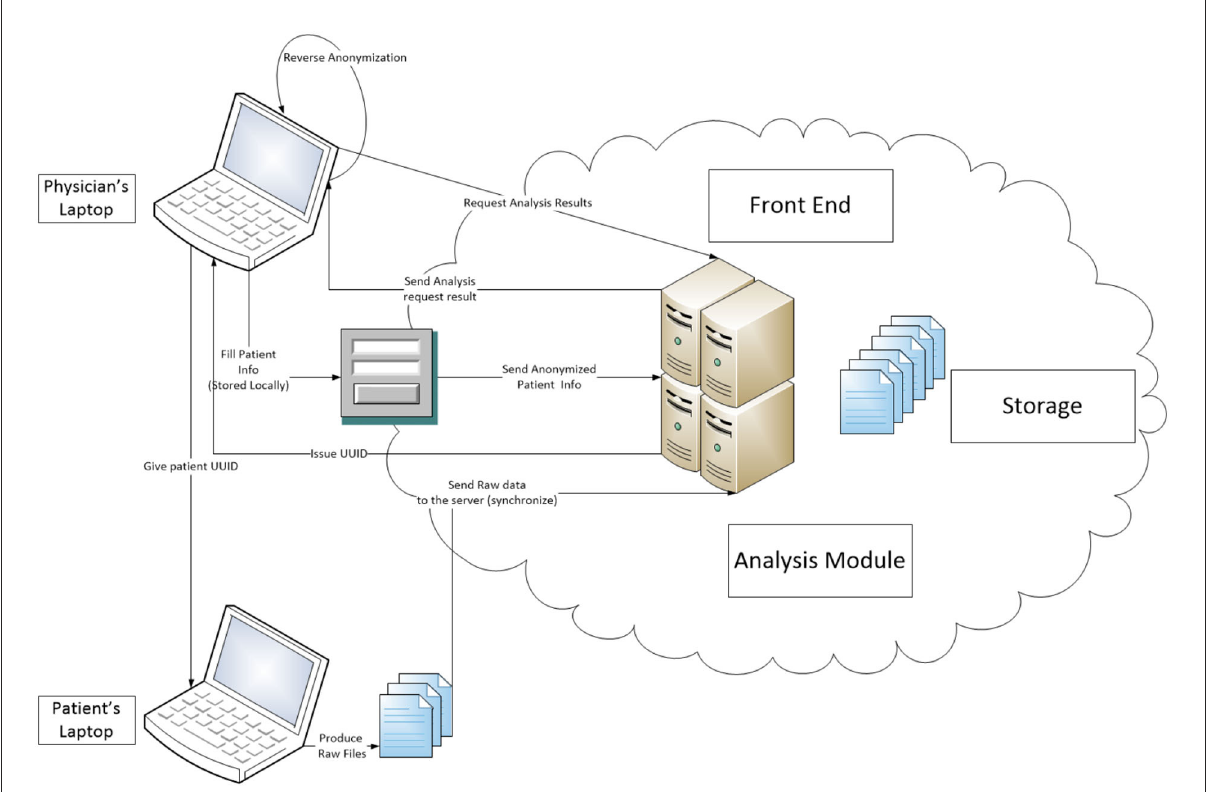
FIGURE8 System’s overall architecture